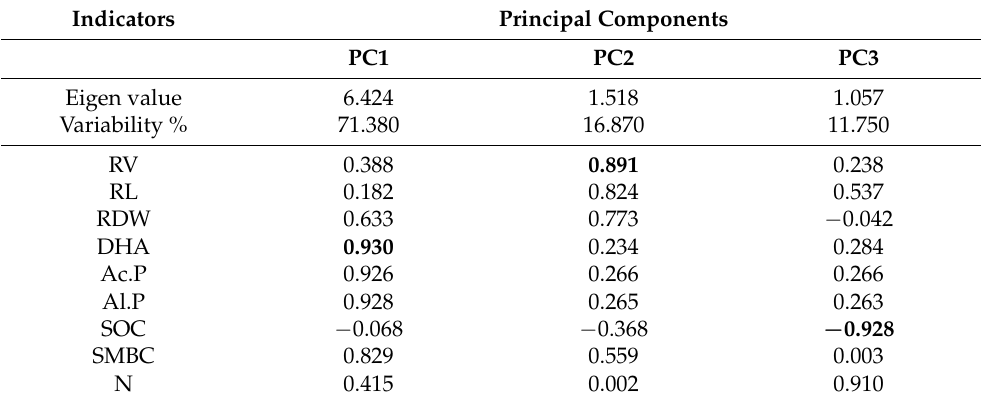
Table 11. Principal component and loading related to soil quality indicators and root